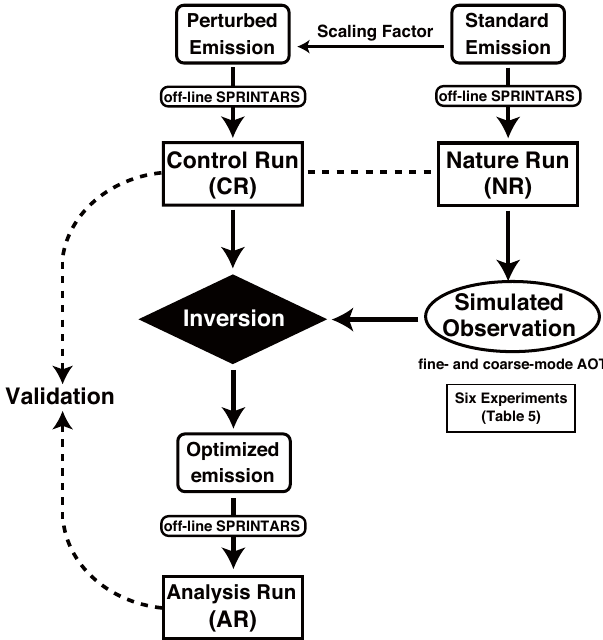
Fig. 5. Schematic diagram of the inversion experiments with the OSSE